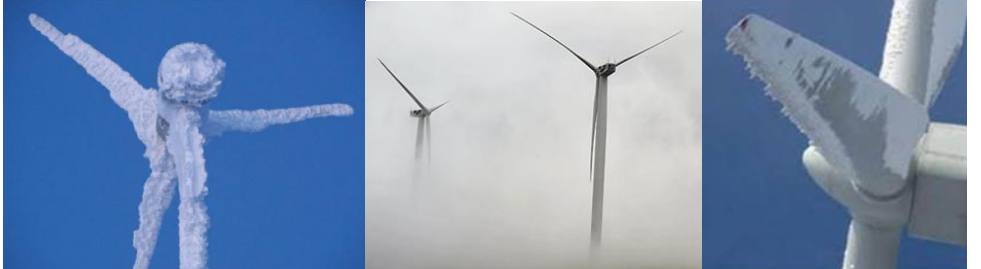
Figure 3. Types of icing [13].